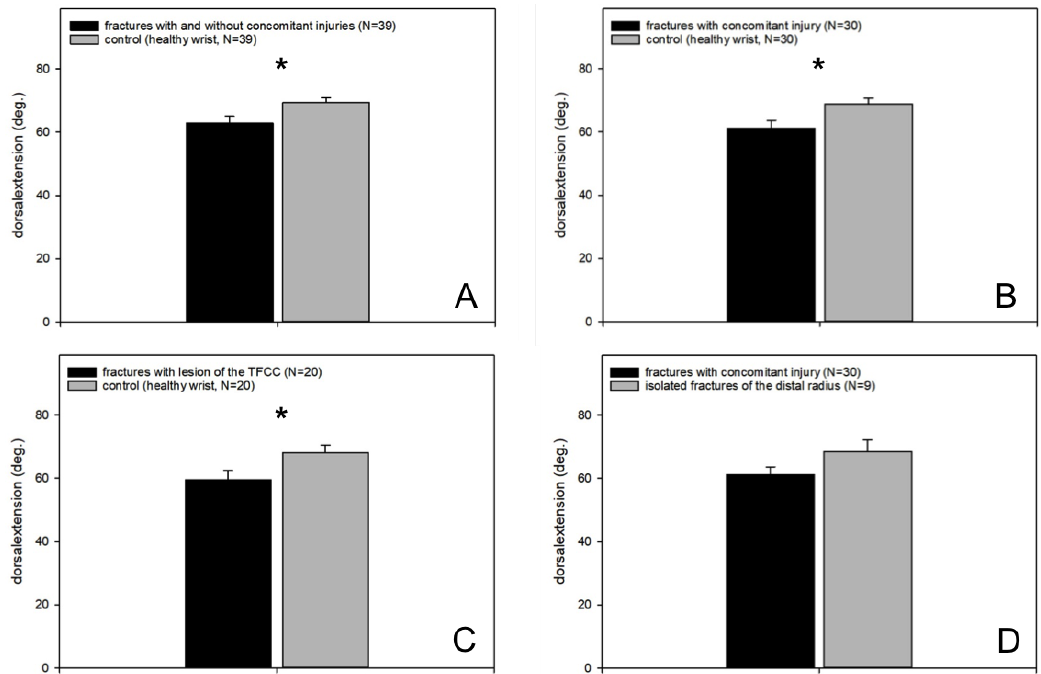
Figure 6. Dorsalextension. ( A ) Significantly reduced dorsalextension in the injured wrist (fracture of the distal radius with and without concomitant injury) compared to the healthy wrist; ( B ) significantly reduced dorsalextension in fractures with concomitant injuries compared to the healthy wrist; ( C ) significantly reduced dorsalextension in fractures with concomitant triangular fibrocartilaginous complex (TFCC) lesions compared to the healthy wrist; ( D ) no difference between patients suffering from isolated distal radius fractures and those with distal radius fractures and arthroscopically treated concomitant lesions.